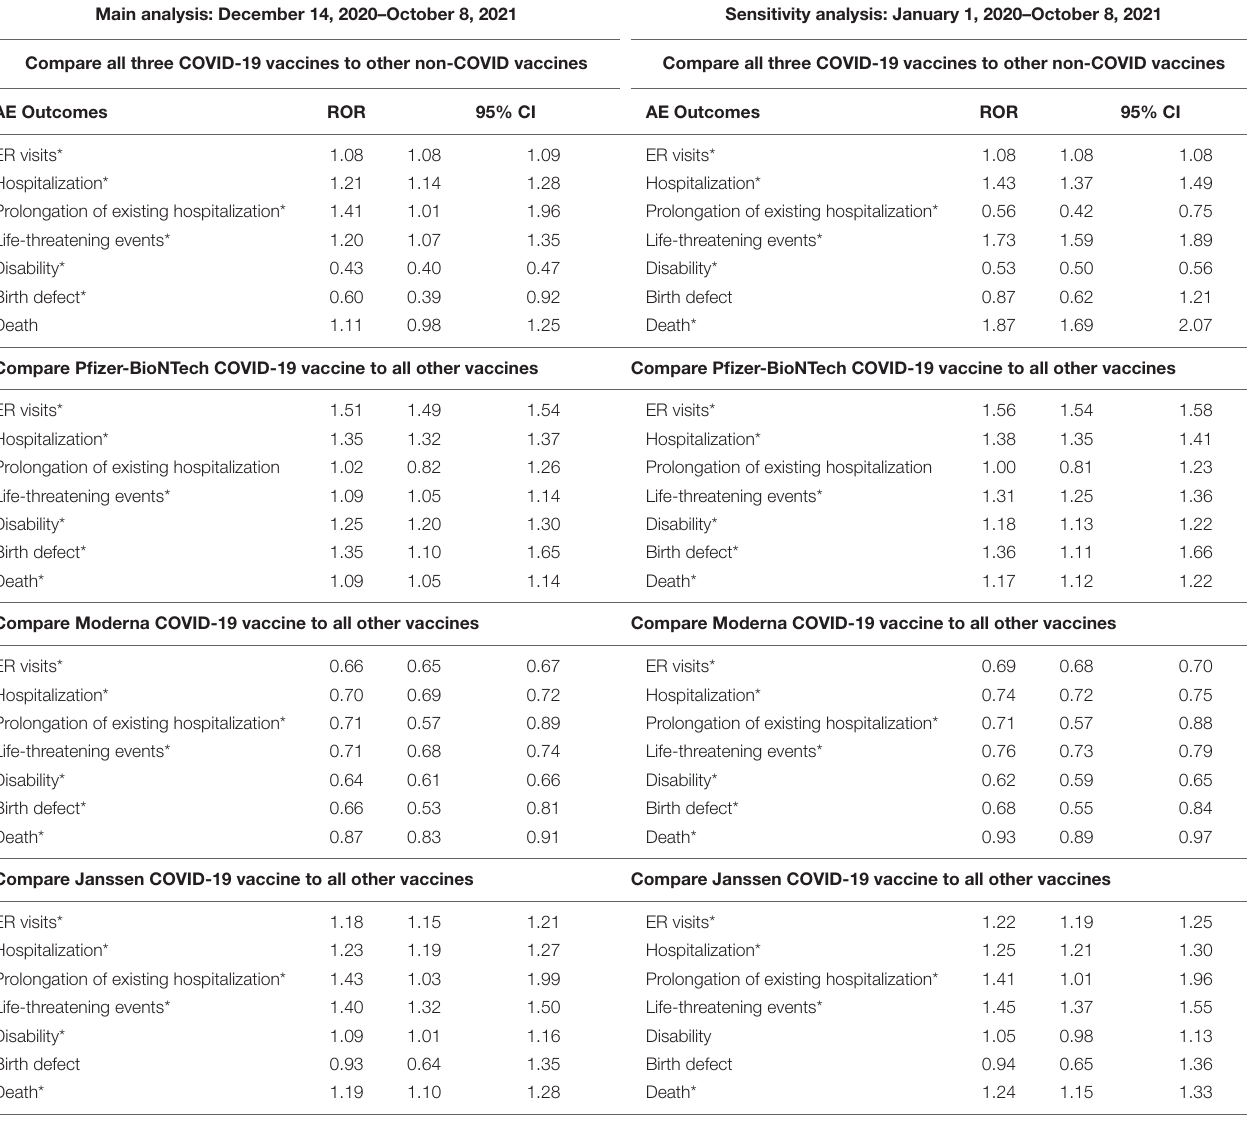
TABLE 4 | Main and sensitivity analyses of RORs for COVID-19 vaccines, overall and by individual COVID-19